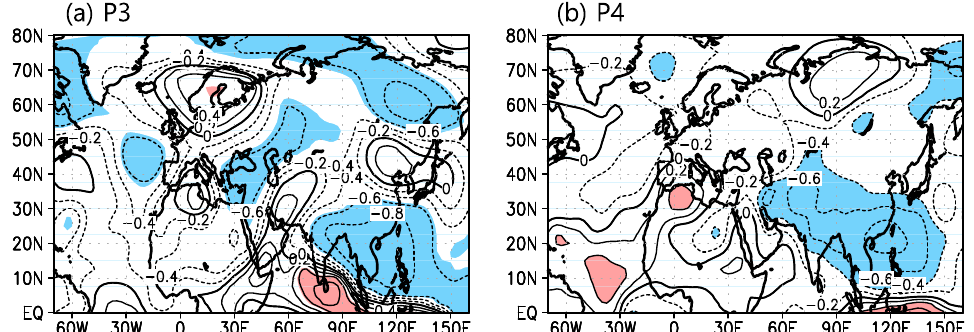
Figure 6. Correlation distributions of the high pass filtered summer stream function at 500 hPa with the EASMI in the Atlantic Ocean and Eurasia in ( a ) 1991–1999 (P3) and ( b ) 2000–2016 (P4). The contour internal is 0.2 and shading shows the significance at the 90% confidence level of the Student’s t -test.